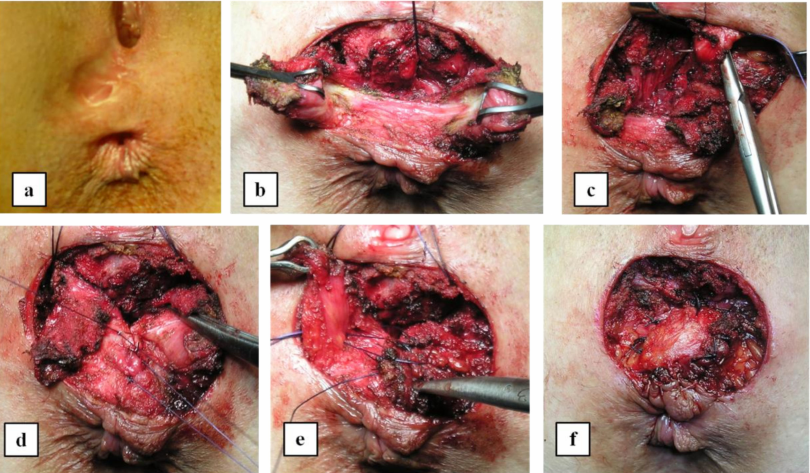
Figure 1. Detailed key technical points concerning an overlapping sphincteroplasty. ( a ): Basal anal inspection. Scar tissue secondary to episiotomy and “smoothing” of anal margin should be